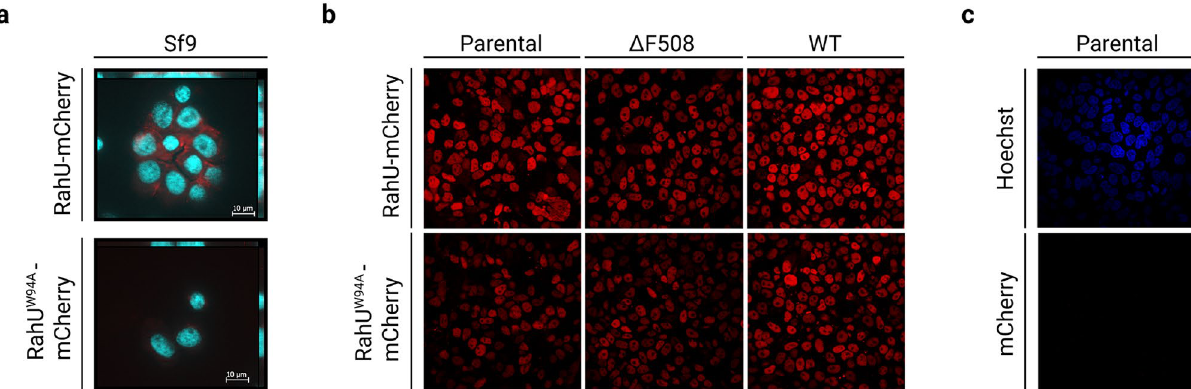
Figure 5. Analysis of RahU interaction with the host cells. Representative fluorescence images depicting ( a ) combined signal of mCherry (red) and DAPI stained nuclei (blue) in fixed Spodoptera frugiperda (Sf9) insect cells, after exposure to 10 µM RahU-mCherry (above) or RahU-Trp94Ala-mCherry (below), showing absence of the signal in the latter. ( b ) Fixed HEK293 cells stained with RahU-mCherry (upper frames) and RahU- Trp94Ala-mCherry (below), showing signal in nuclei of Parental cells not expressing CFTR and serving as negative control (left column), ΔF508 HEK293 cell line with CFTR mutation causing cystic fibrosis and wild type HEK293 cell line expressing CFTR (right column). ( c ) Fixed HEK293 cells depicting blue Hoechst33342 signal in nuclei (upper frame) and absence of red signal after mCherry staining